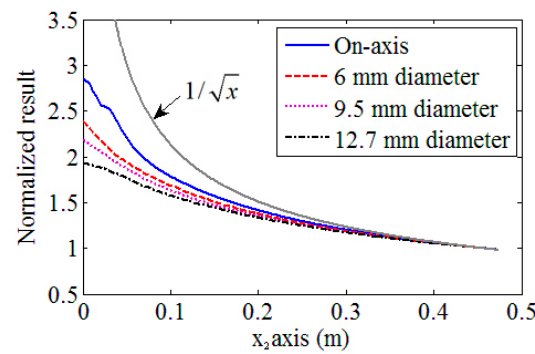
Figure 9. Tendencies of the received wave results using different sizes of receivers. Attenuations are neglected in the simulations.